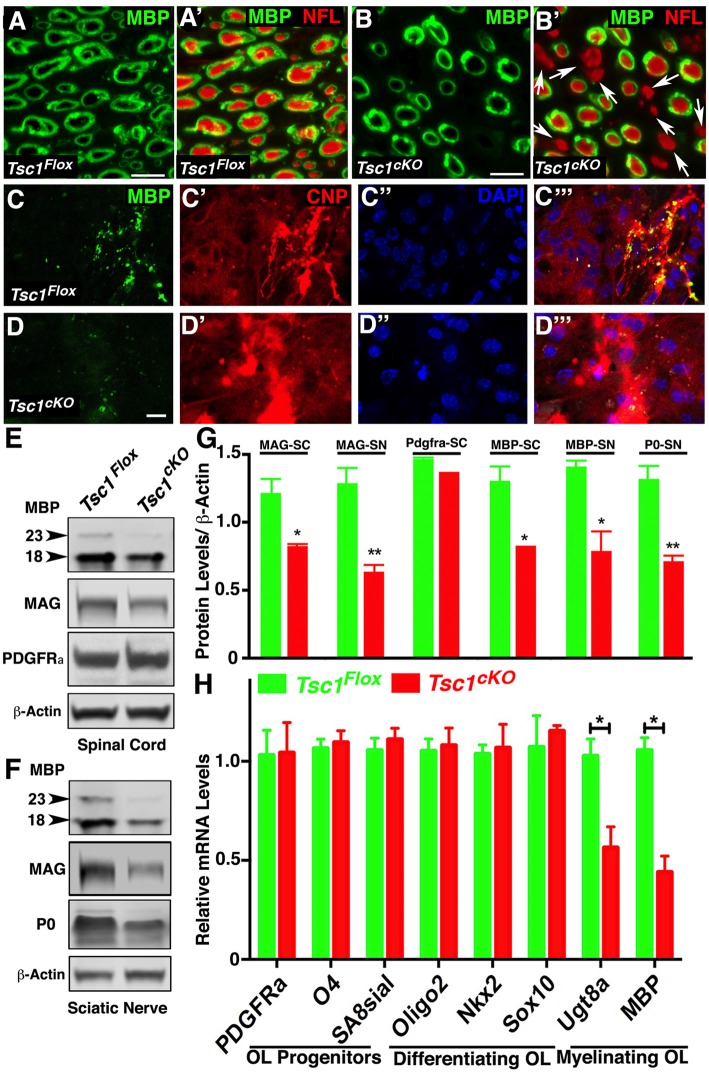
Loss of Tsc1 in myelinating glia affects the myelination phase leading to axonal hypomyelination. (A,B) Immunostaining of cross cryosections of sciatic nerves from P15 Tsc1Flox
(A) and Tsc1cKO
(B) mice with antibodies against myelin basic protein (MBP; green; A,A’,B,B’) and pan-Neurofilament (NFL, red, A’,B’). White arrows indicate axons lacking MBP immunostaining surrounding axonal NFL (red). (C,D) Immunostaining of differentiated oligodendrocyte progenitor cell (OPC) cultures derived from P15 Tsc1Flox
(C,C’,C”,C”’) and Tsc1cKO
(D,D’,D”,D”’) mice, with antibodies again MBP (green) and Cnpase (red). DAPI was used as the labeling for nuclei. (E,F) Western blot analysis of MBP, myelin-associated glycoprotein (MAG) and PDGFRa proteins in SC (E) and MBP, MAG and P0 in sciatic nerves (F) from P15 Tsc1Flox and Tsc1cKO mice. β-actin was used as loading control. (G) Quantification of immunoblots shown in (E,F), *p < 0.05, or **p < 0.01. (H) RT-qPCR analysis of key differentiation genes in SCs from P15 Tsc1Flox (green) and Tsc1cKO (red) mice. Comparisons between genotypes were performed by Student t-test. n = 5, *p < 0.5. Scale bar: (A–E) = 2 μm.